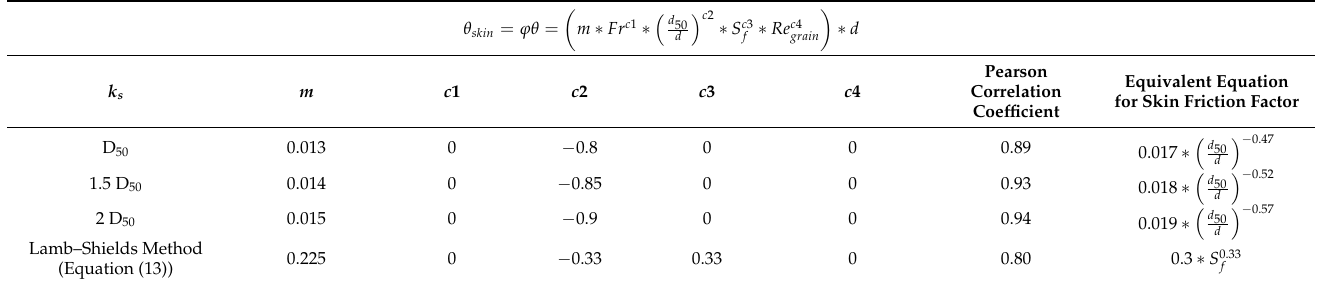
Table 2. Calculated parameters to determine modified momentum thickness emerged by skin friction for different equivalent roughness in the Keulegan